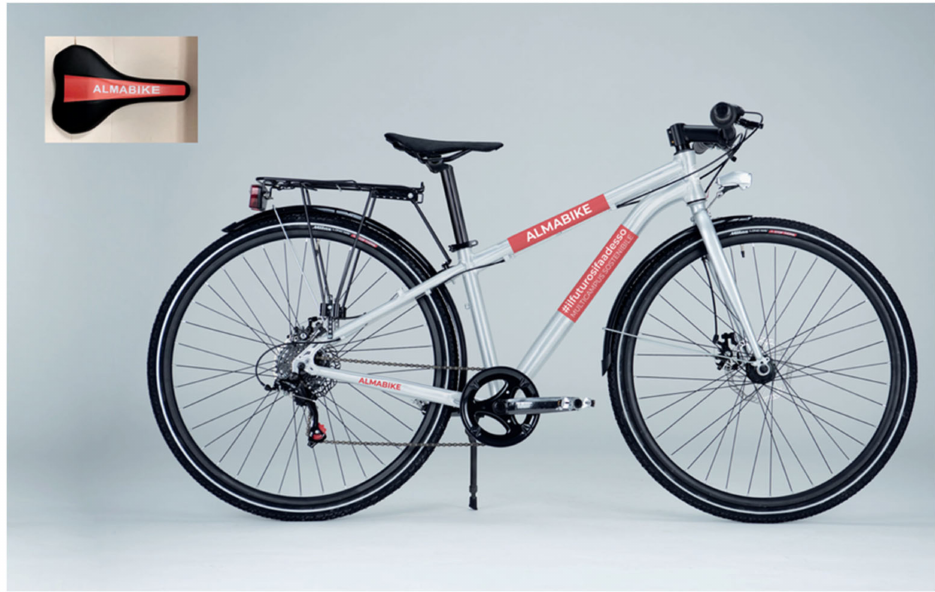
Figure 2. Almabike